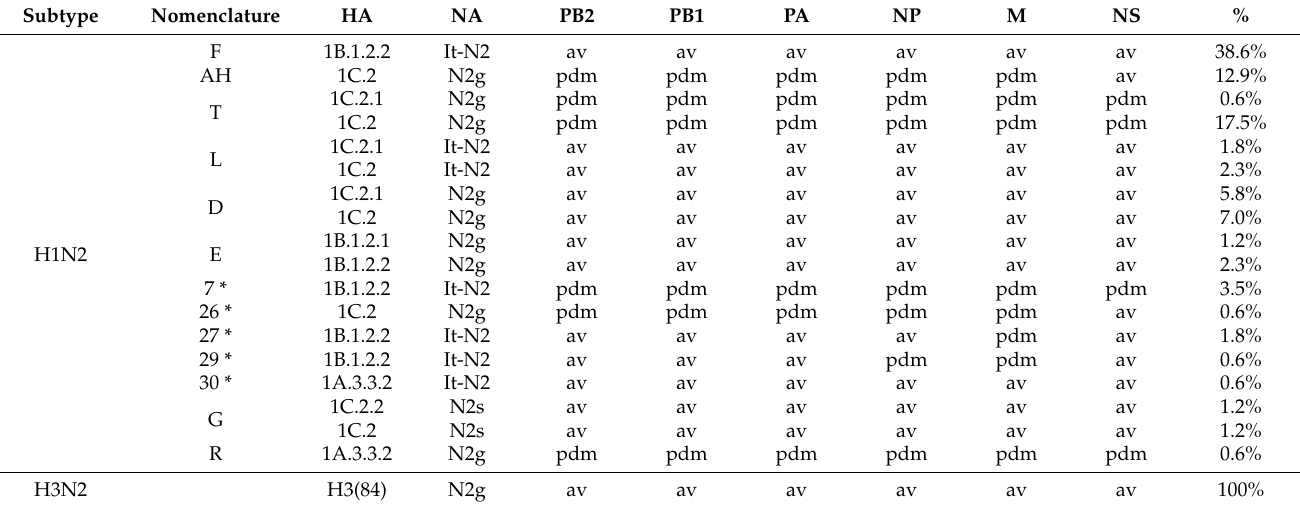
Table 3. List of genotypes detected among 171 analyzed H1N2 strains and 55 H3N2 and relative percentages. Genotype nomenclatures assigned as described previously [5,6]. Undescribed genotypes (*) are numbered arbitrarily [19]. H1-clade are classified according to [8], and H3(84) correspond to Ghent-like. NA lineages assigned as described in [5,6] (N2g Ghent-like; N2s, Scotland-like; It-N2; A/swine/Italy/4675/2003).